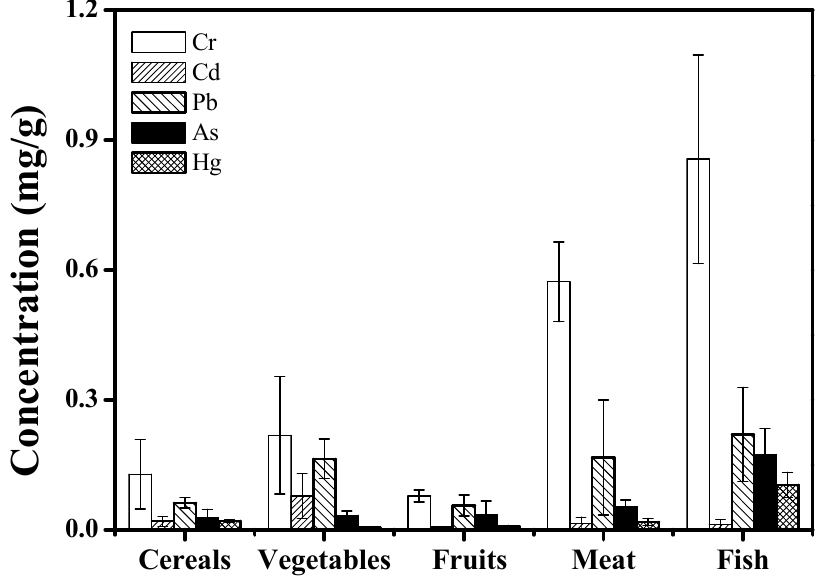
Figure 1. Mean metal concentrations of different species (mg/kg) (dry weight).